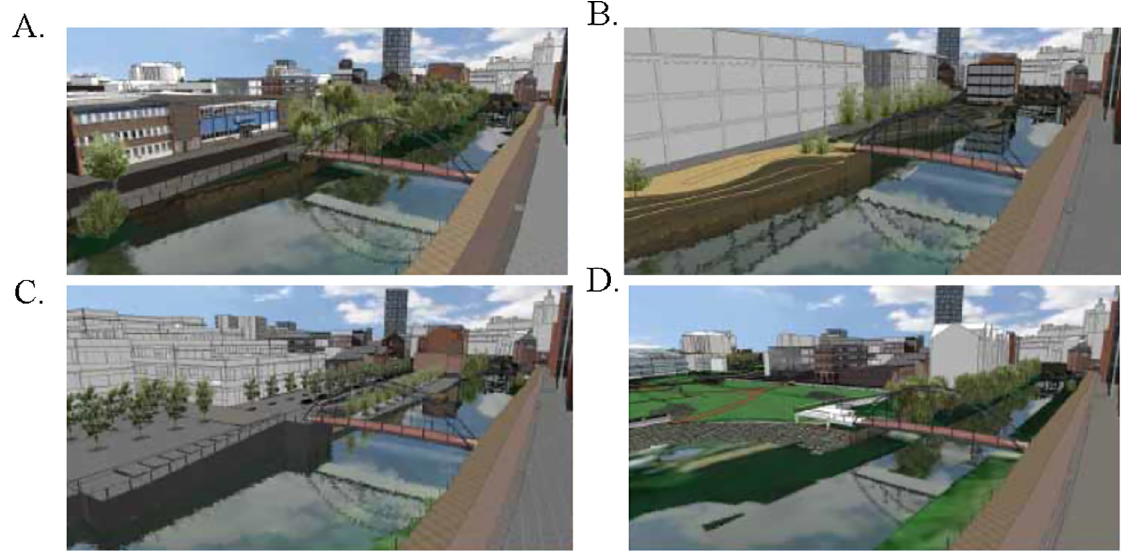
Fig 11. Comparison of different design